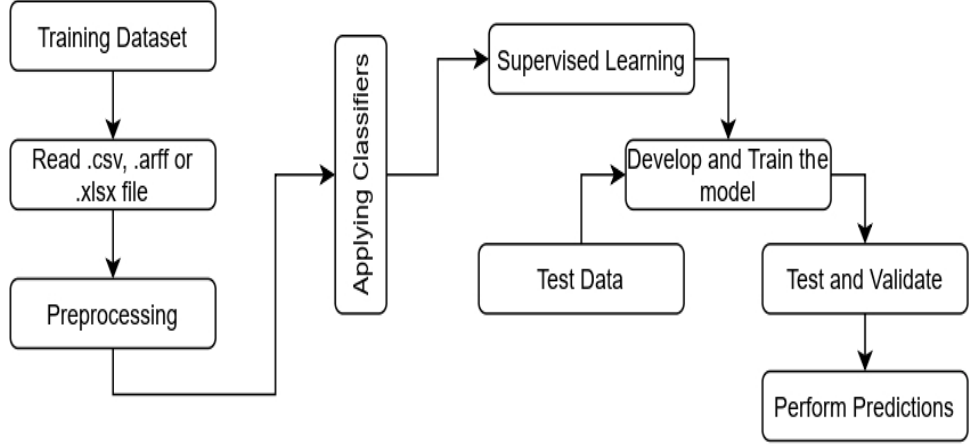
Figure 1. Workflow of classification models for predictive analytics.